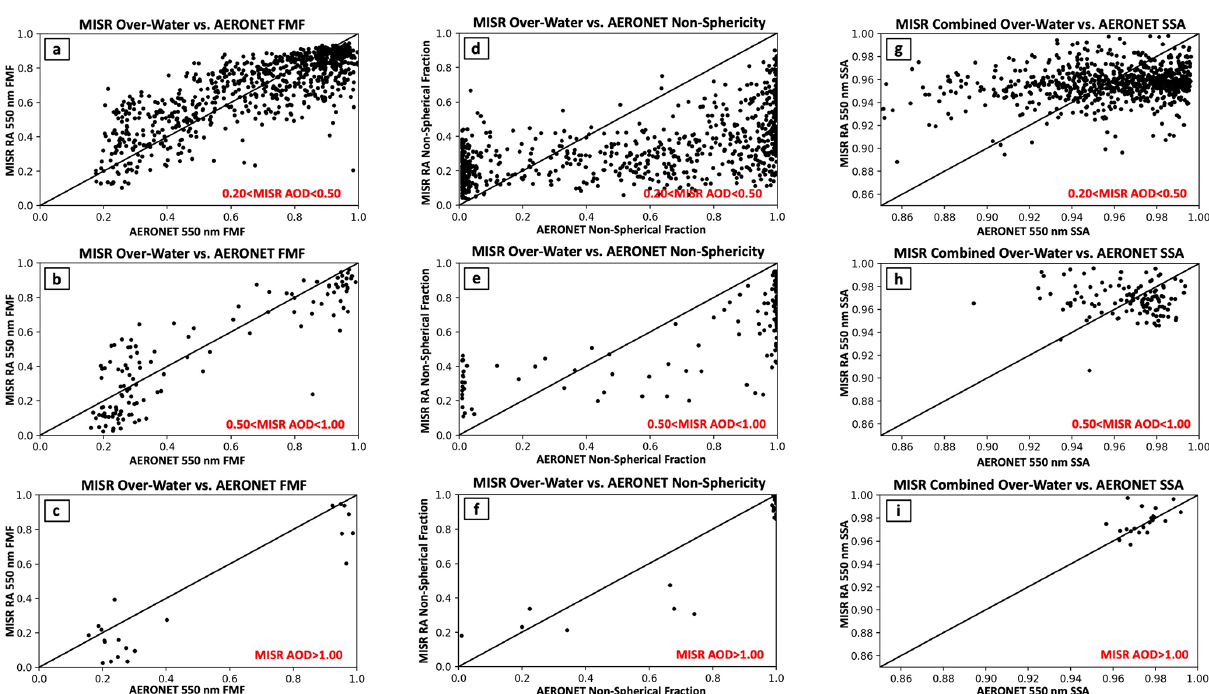
Figure 9. Same as Fig. 5, except for the MISR over-water retrieval. Note the different AOD (compared to Fig. 5) bounds embedded in